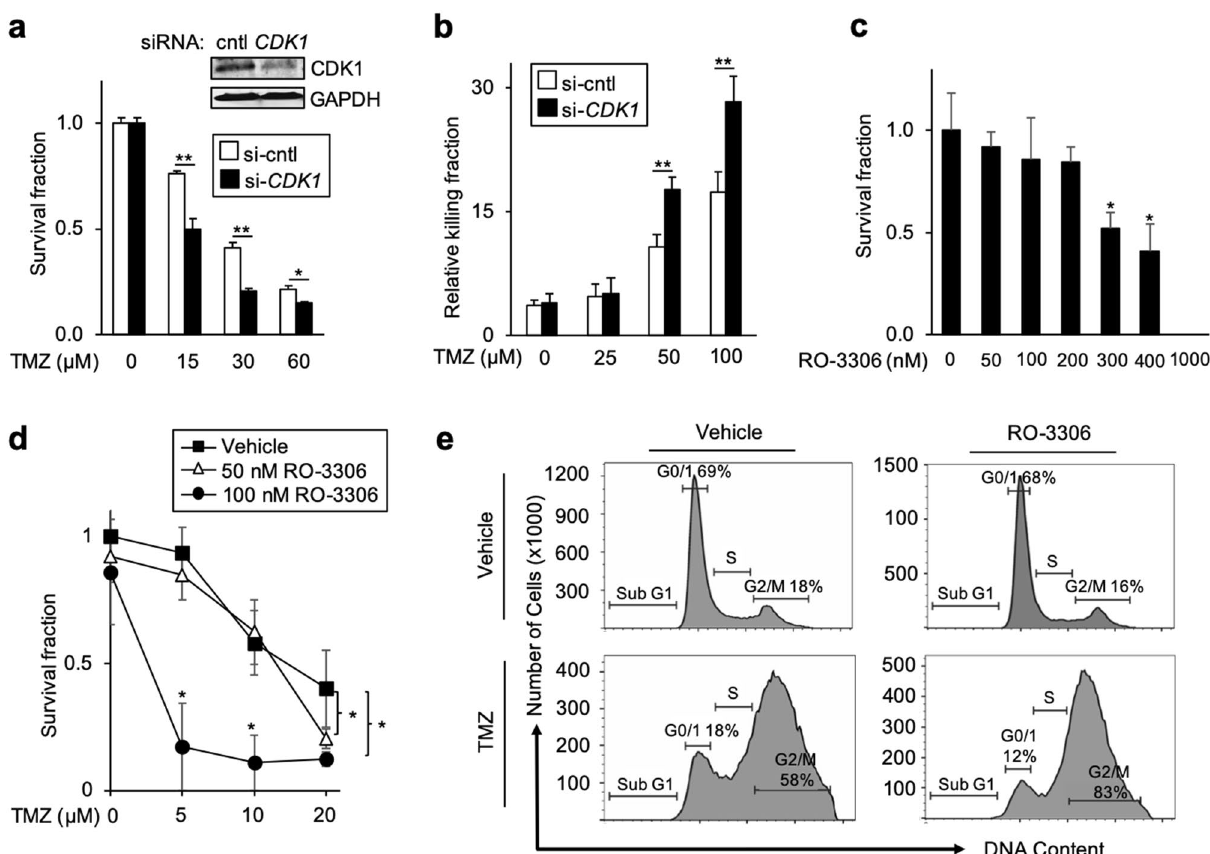
Figure 5. Depletion of CDK1 sensitizes cells to TMZ. ( a ) Clonogenic assay in U87 cells transfected with si-control or si- CDK1 and treated with TMZ. Inset: Immunoblot with anti-CDK1 and anti-GAPDH. ( b ) Trypan blue assay in GBM34 GSCs transfected with si-control or si- CDK1 following treatment with TMZ (72 h). ( c ) Clonogenic survival in U87 cells treated with the indicated concentration of RO-3306. ( d ) Clonogenic survival in U87 cells treated with RO-3306 and TMZ. ( e ) Flow cytometric analysis of DNA content after staining with propidium iodide in U87 cells 72 h after treatment with 100 nM RO-3306 and 20 μM TMZ, repeated with similar results. Clonogenic survival data demonstrate mean number of colonies relative to plating efficiency, ± SD of triplicate samples normalized to untreated sample. IB data representative of duplicate experiments. * P < 0.05, ** P <